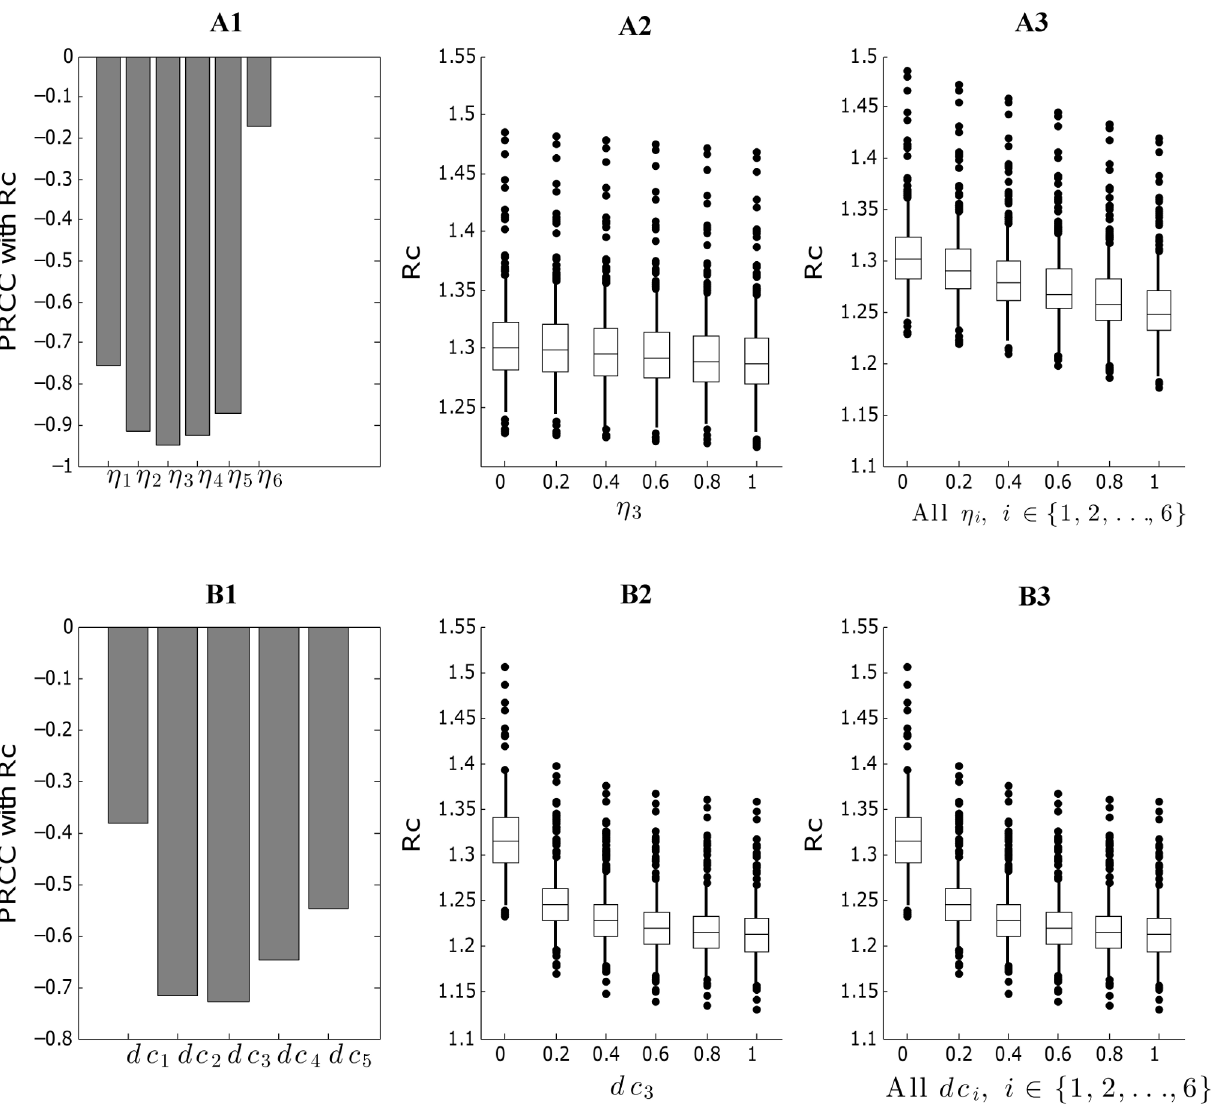
Figure 5. PRCC and R c under different intervention strategies. Upper panel: PRCC of g a ( a [ f 1,2, ... ,6 g , level of contact reduction in age group a ), with R c based on a sample of size 100 using LHS (A1); R c for different levels of contact reduction under uncertainty of other model parameters (A2); and R c for different level of population-wide contact reduction under the uncertainty of other parameters(A3). Lower panel: PRCC of dc a ( a [ f 1,2, ... ,6 g , decolonization treatment coverage in age group a ), with R c based on a sample of size 100 using LHS (B1); R c for different levels of decolonization treatment coverage under uncertainty of other model parameters (B2); and R c for different levels of population-wide decolonization treatment coverage under the uncertainty of other parameters (B3).